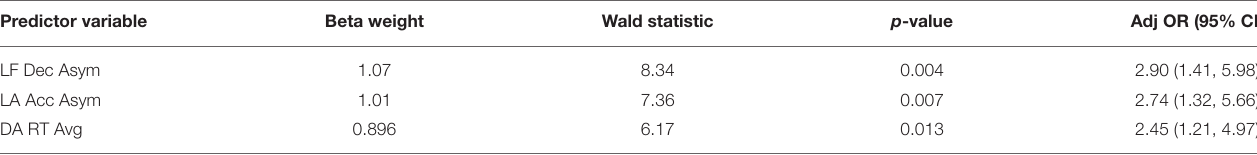
TABLE 4 | Logistic regression results for the final three, predictor, binary variables. Predictor